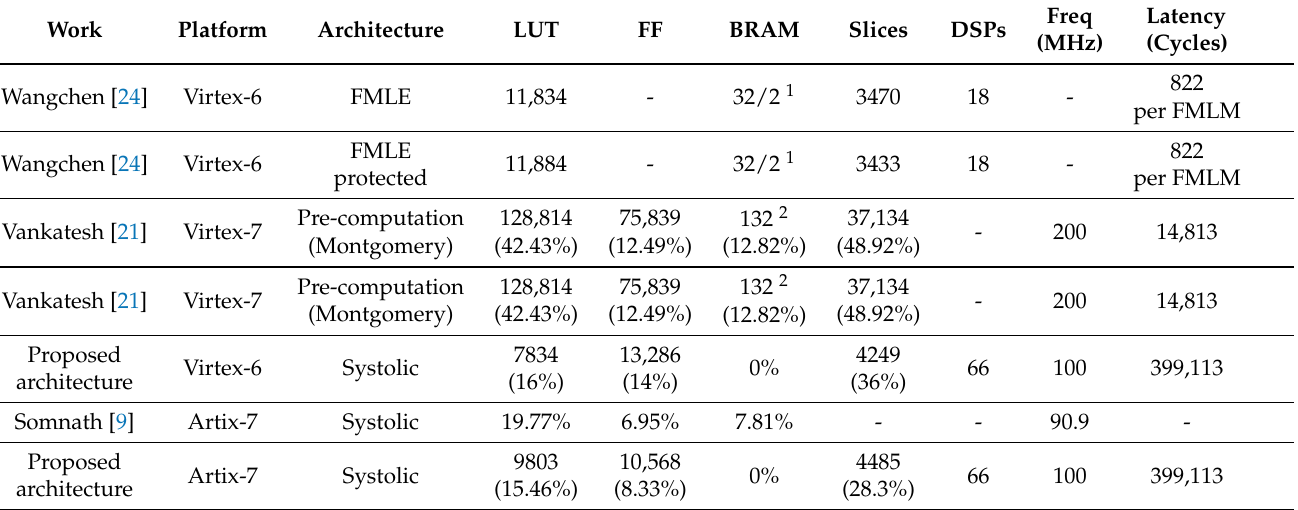
Table 6. Performance comparison of the State-of-the-Art Modular Exponentiation with N =